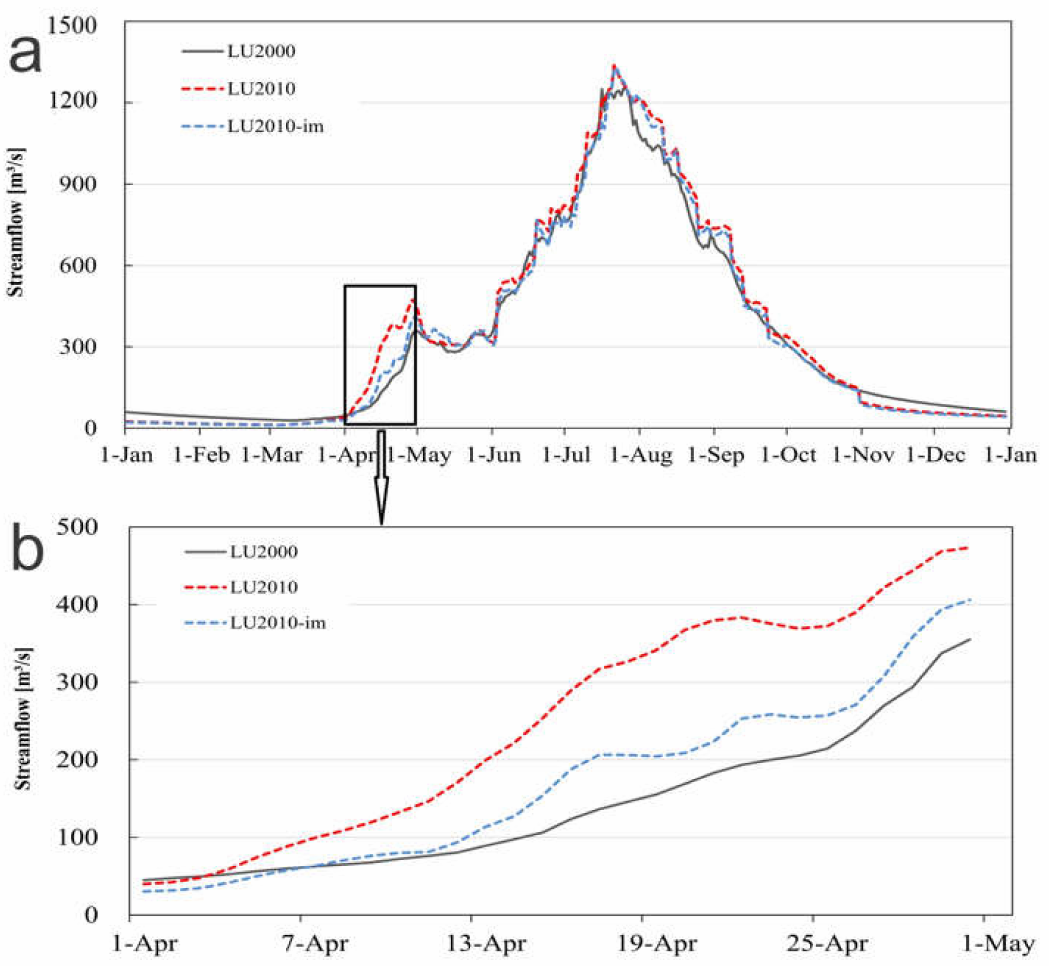
Figure 6. Simulated annual average daily streamflow at the basin outlet (SUB21) (m 3 s) (mean 2002–2007): comparison of the LU2000 model (base period model), LU2010 model and LU2010-im model for (a) the annual average daily streamflow and (b) in